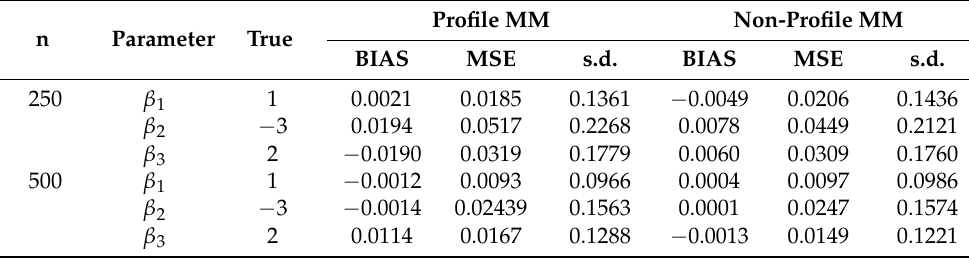
Table 4. Parameter estimation results in Scenario